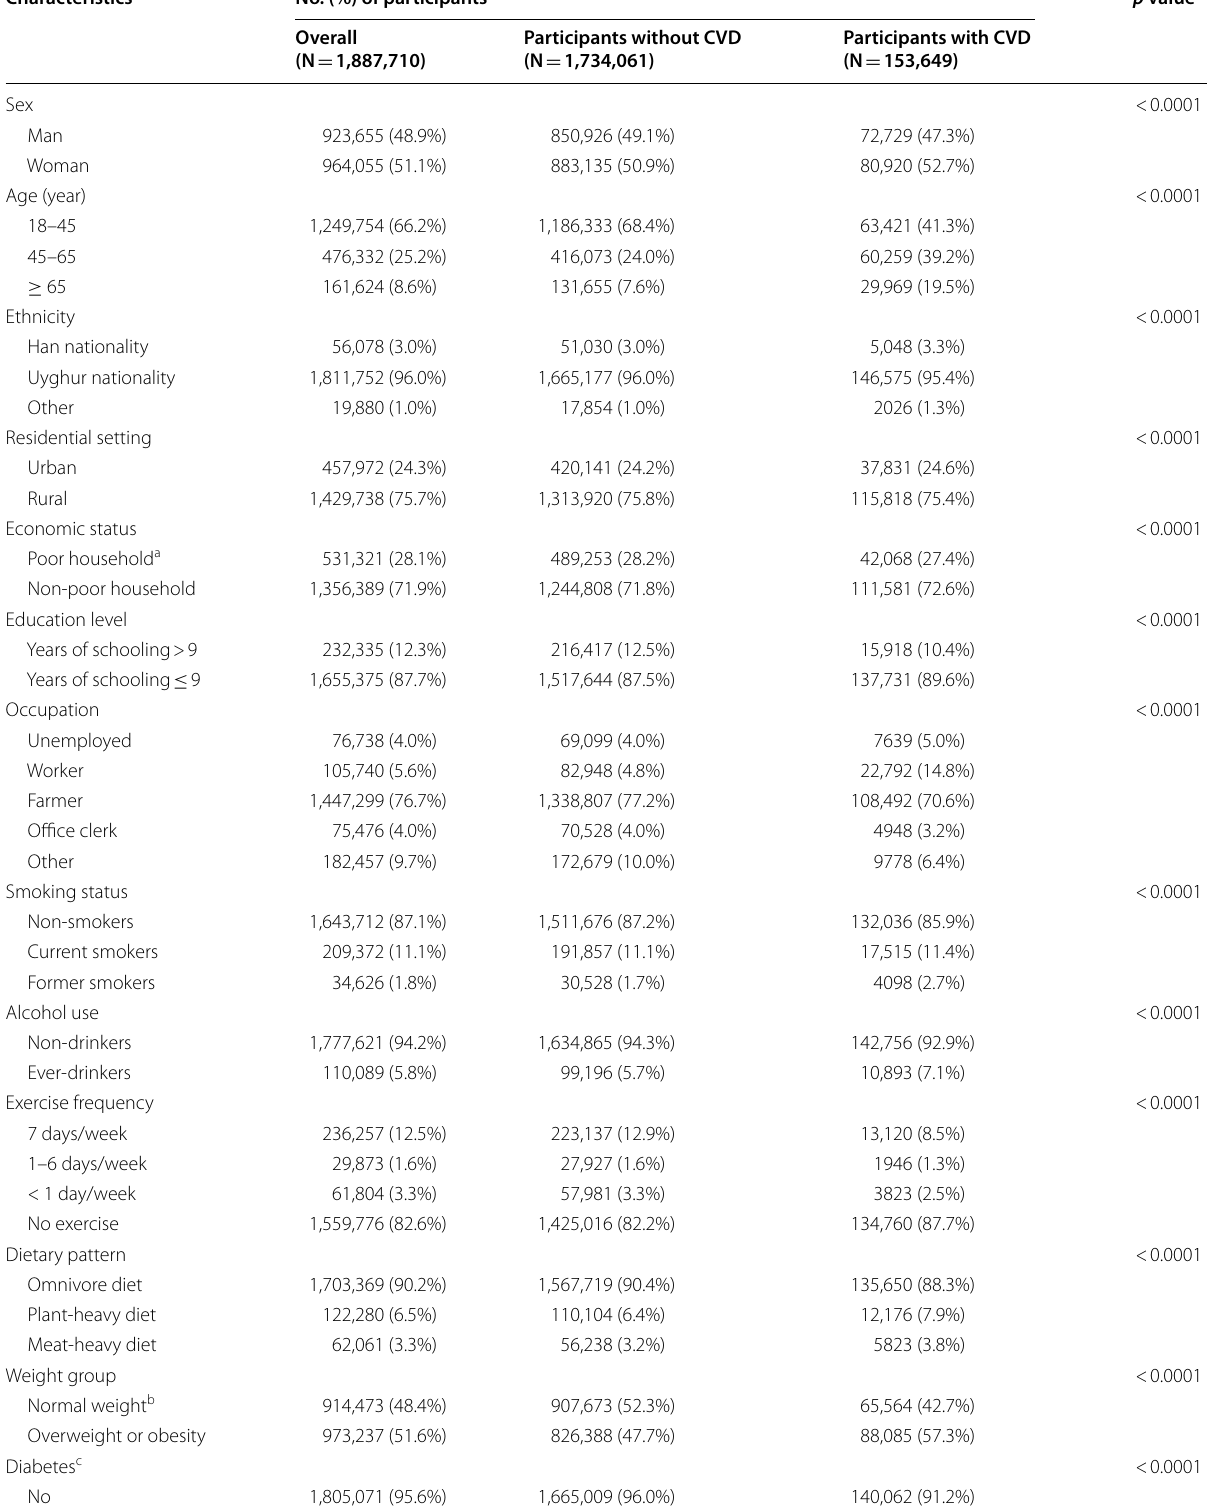
Table 1 Characteristics of study participants by CVD group